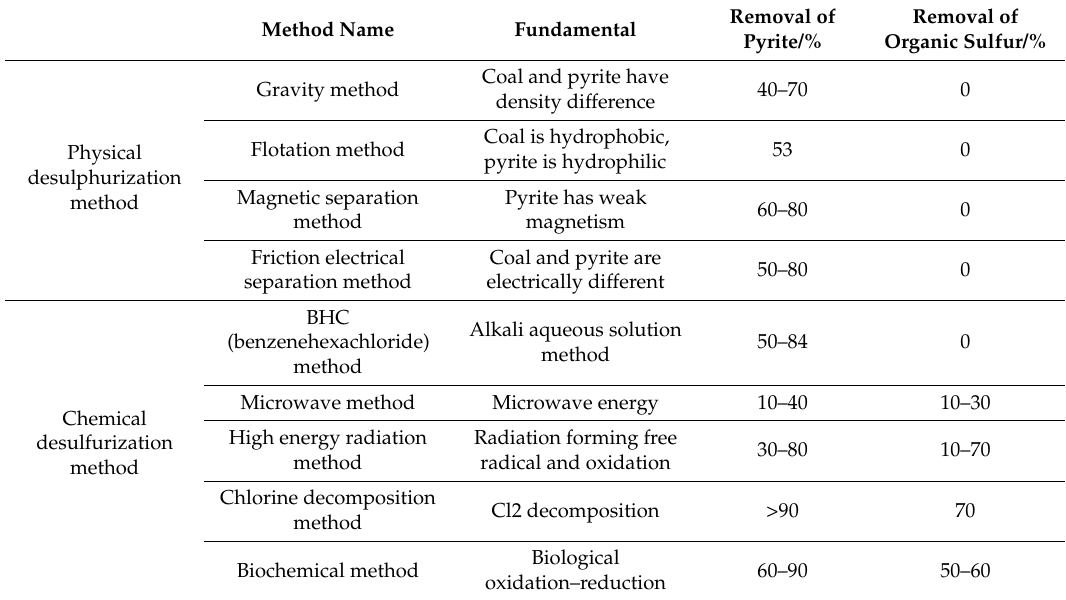
Table 1. Summary of partial desulfurization methods and desulphurization